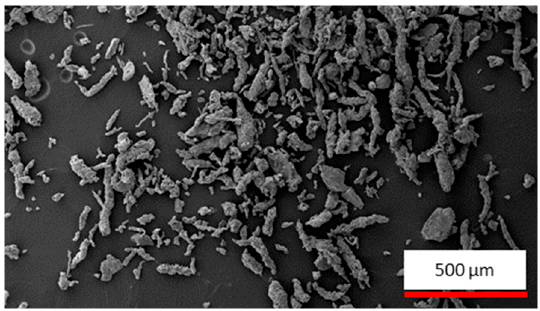
Figure 2. Microscopy images of collected tire particles at different magnifications.